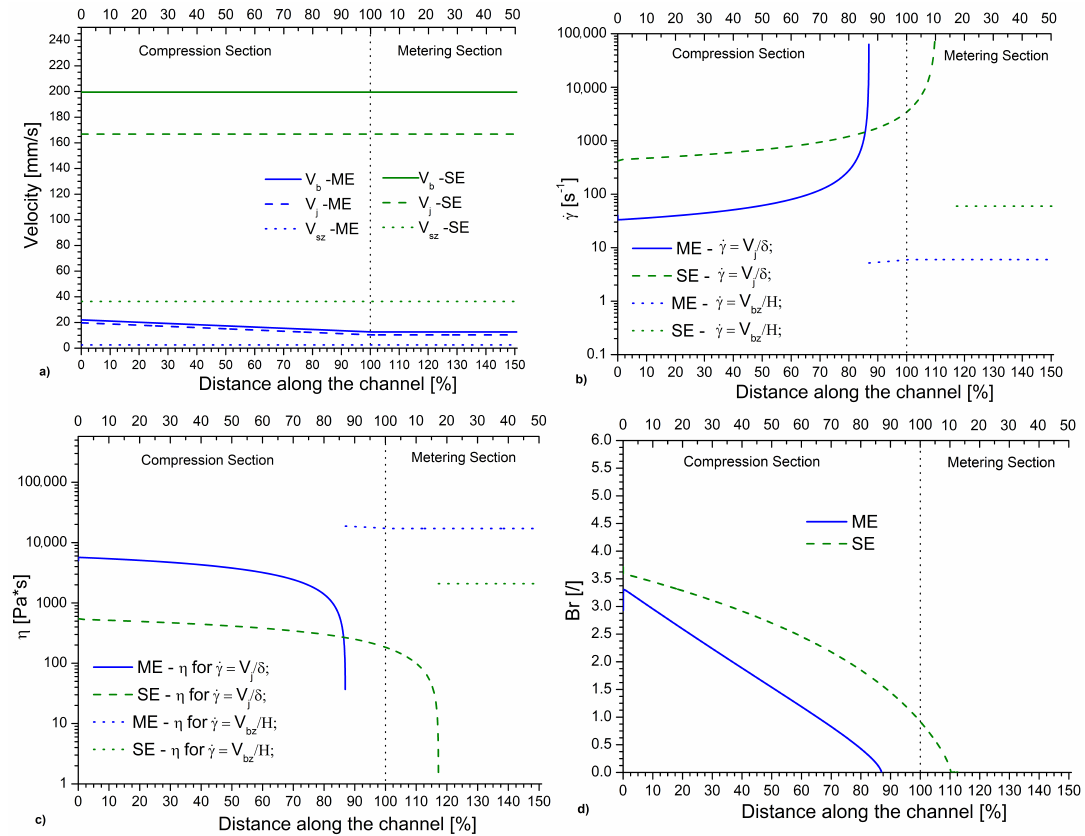
Figure 6. ( a ) Variation of velocities in compression and metering section for micro-extrusion (ME) case (blue full line, material properties, dimensions and settings from Table 1, Column 2 and conventional / standard extrusion (SE) case with same screw speed and barrel temperature (red dashed line, material properties, dimensions and settings from Table 1, Column 4; ( b ) corresponding variation of shear rates that are in the compression section defined based on the relative velocity and the melt layer thickness and in the metering section (strictly as soon as the melting is done) based on the total channel height and the drag flow definition; ( c ) the associated variation of viscosity; and ( d ) the associated variation of the Brinkman